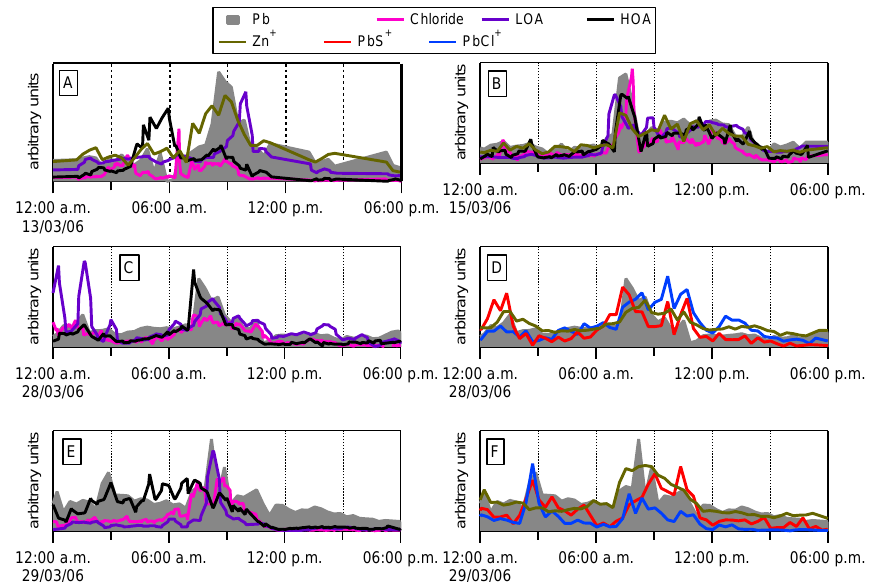
Fig. 12. Time series of aerosol components: Pb mass concentration, 64 Zn + , 208 PbS + and, 208 PbCl + open signals (this work) and chloride, HOA, and LOA mass concentration from Aiken et al. (2009) on four different days at T0. LOA and HOA are AMS-PMF factors correspond- ing to hydrocarbon-like organic aerosol and a local primary nitrogen-containing organic aerosol, respectively. Panels (A) and (B) show time series on 13 and 15 March, respectively; no concentrator data (PbS + and PbCl + ) is available for those days. Panels (C) and (D) show data on 28 March and panels (E) and (F) show 29 March